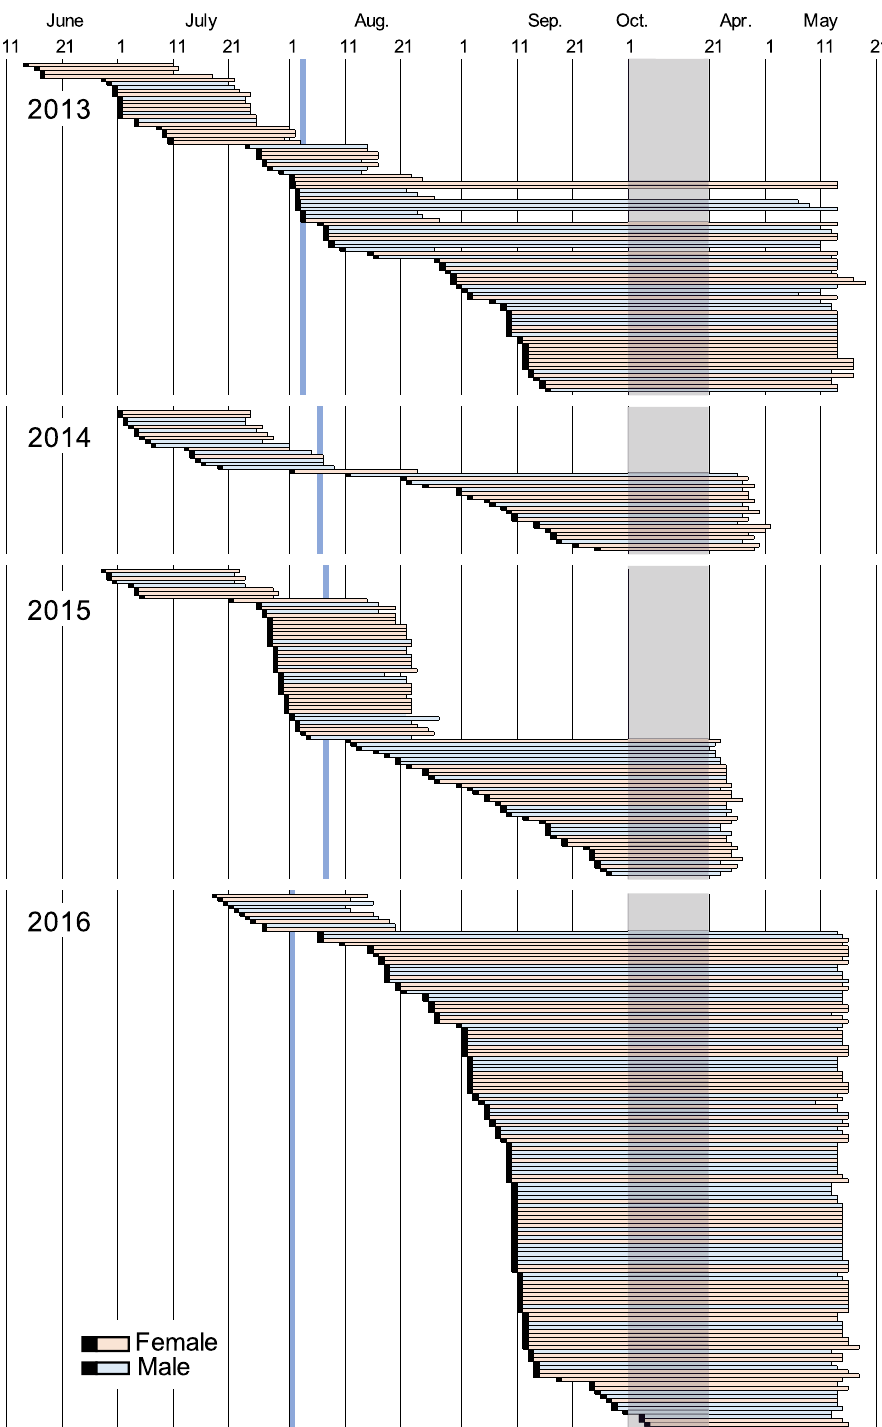
Figure 2. Developmental periods from egg to adult emergence based on the rearing data for individual wasps of Dipogon sperconsus during 2013–2017. Each horizontal bar shows the period from the estimated day of oviposition (indicated by the black beginning of bar) to the day of adult emergence (indicated by the end of bar) for an individual wasp (see Supplementary Tables S9–S12). Narrow blue areas show the 50% overwinter-egg days in each year (see text). A broad gray area represents the winter